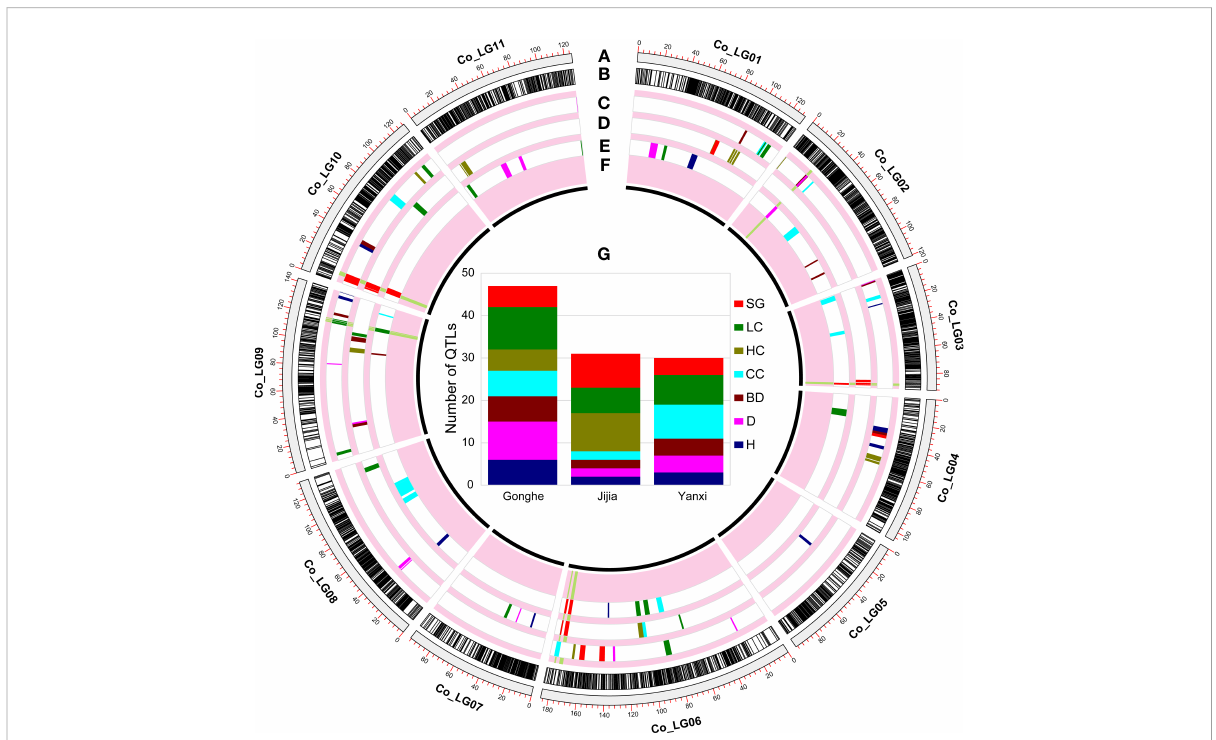
FIGURE 3 QTL mapping in multiple environments. (A) are the genetic distance in cM. (B) are the distribution of all loci in the consensus map. And the distribution of QTLs of growth and wood properties detected in Gonghe (C) , Jijia (D) and Yanxi (E) environments. (F) are stable QTLs. (G) are QTL statistics for each trait at each